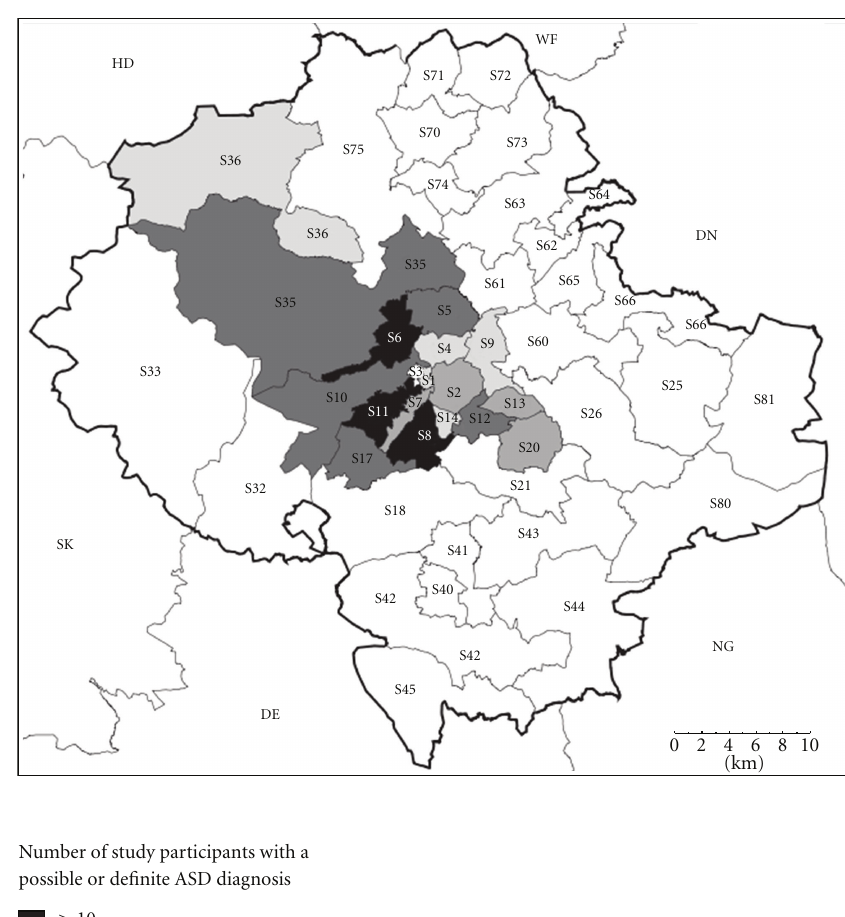
Figure 2: Spatial distribution by postcode of HFPDD cases in the city of She ffi eld (greater She ffi eld postcodes outside city are shown as